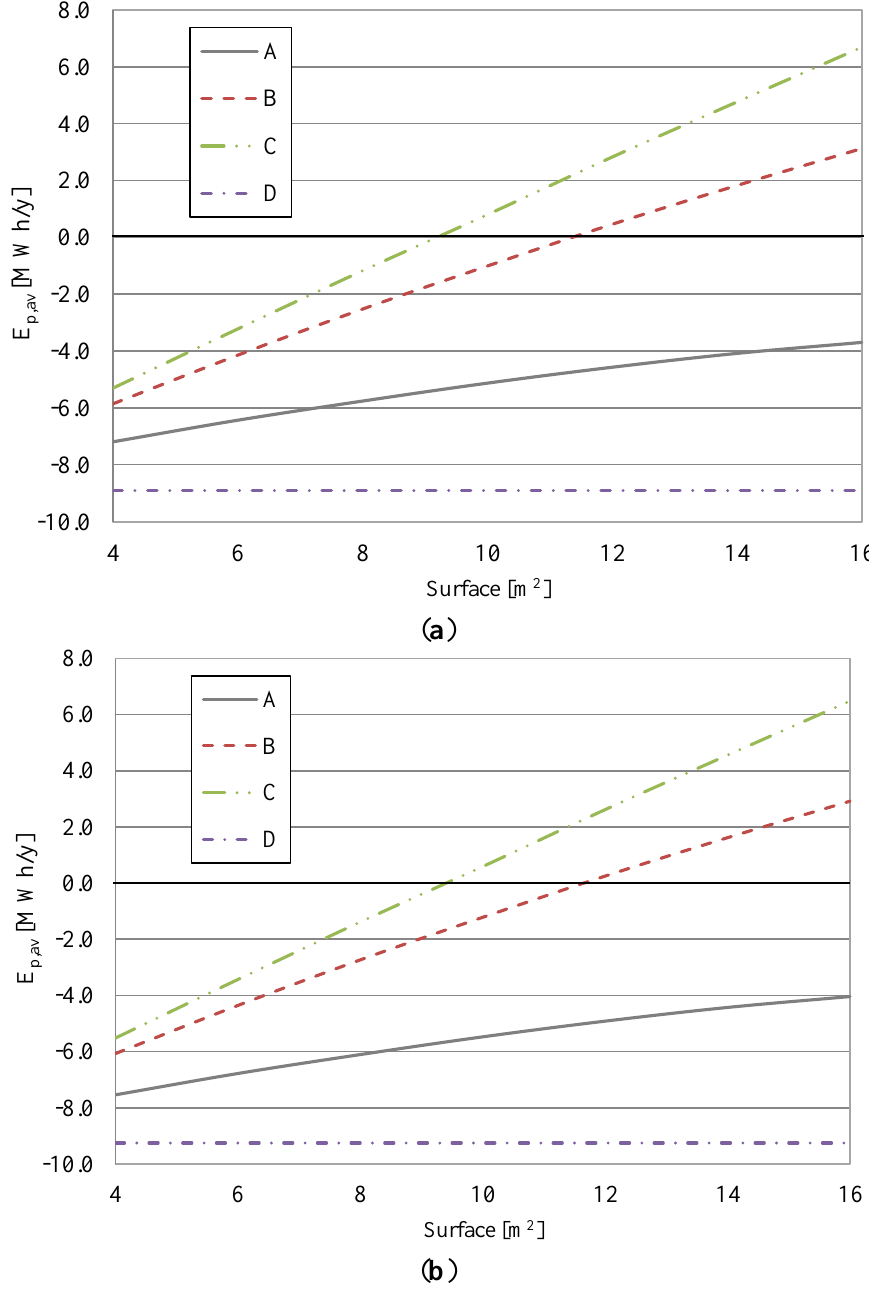
Figure 6. ( a ) Annual avoided primary energy consumption considering the current Italian situation and ( b ) the best available technology for electricity supply. Scenarios A (air collectors), B (flat-plate collectors), C (evacuated tube collectors) and D (natural gas